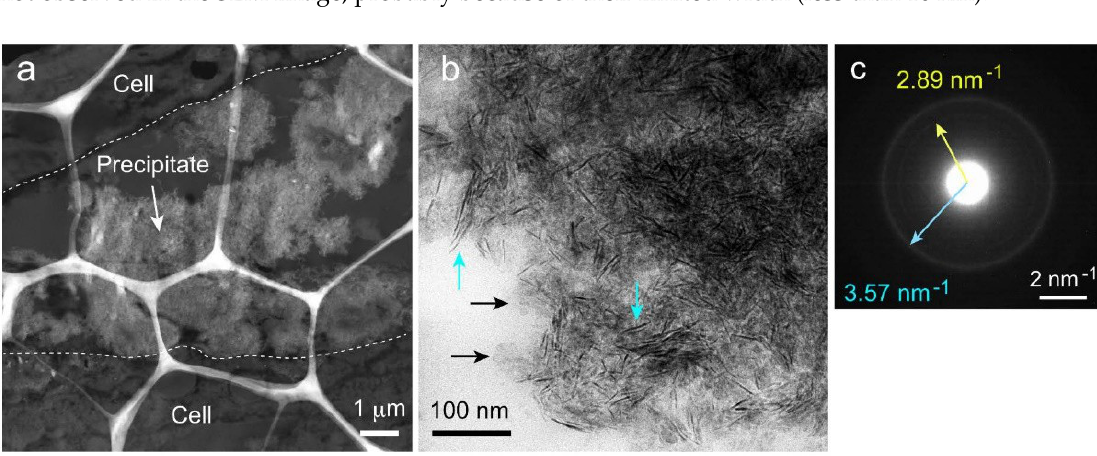
Figure 7. Wide-area TEM images of precipitates. ( a ) Low-magnification image of a microtome-cut sample. The dotted line shows the boundary between the cell sheet and precipitate region. ( b ) High- magnification image of precipitates. Many nanorods (light blue arrows) and bulky materials (black arrows) were observed. ( c ) Selected-Area Electron Diffraction ( SAED) pattern measured at 800 nm . Two Debye rings (low and high intensities) were observed.